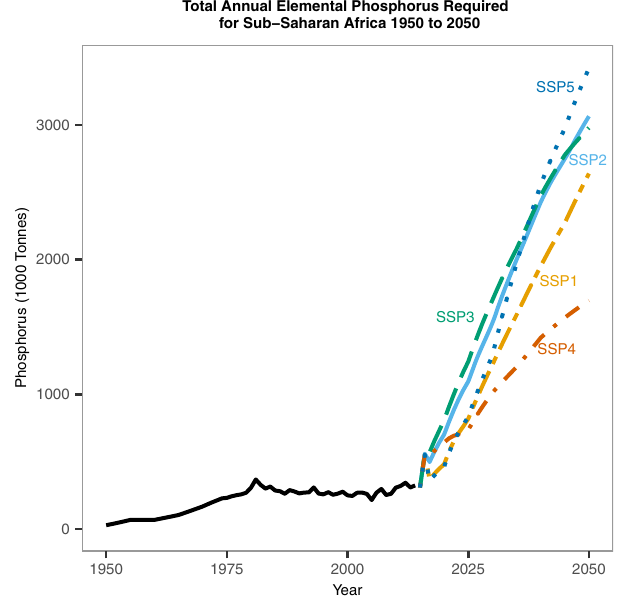
Fig. 2 | Total elemental phosphorus required (1000 tonnes) in Sub-Saharan Africa from 1950 to 2050 (black line). Using the model and input data the total elemental phosphorus required (1000 tonnes) has been estimated from 2020 to 2050 under different Share Socioeconomic Pathways (SSP1-SSP5) 27 within IMAGE3.2 framework 28